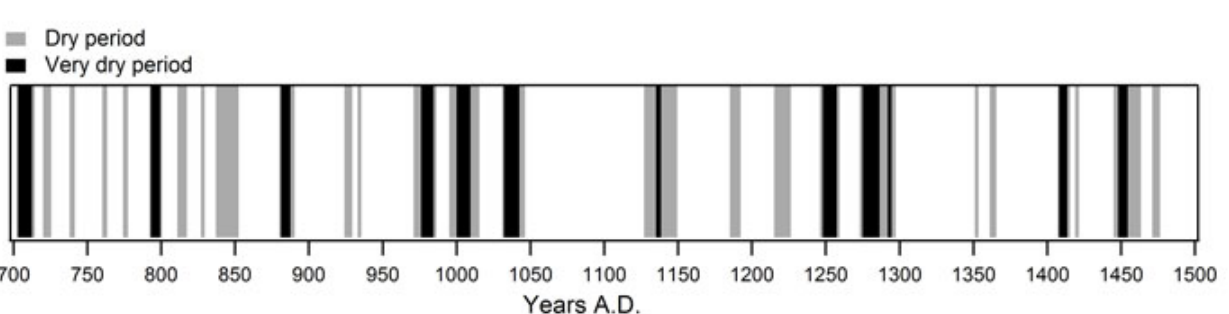
Fig. 3 . Mimbres climatic